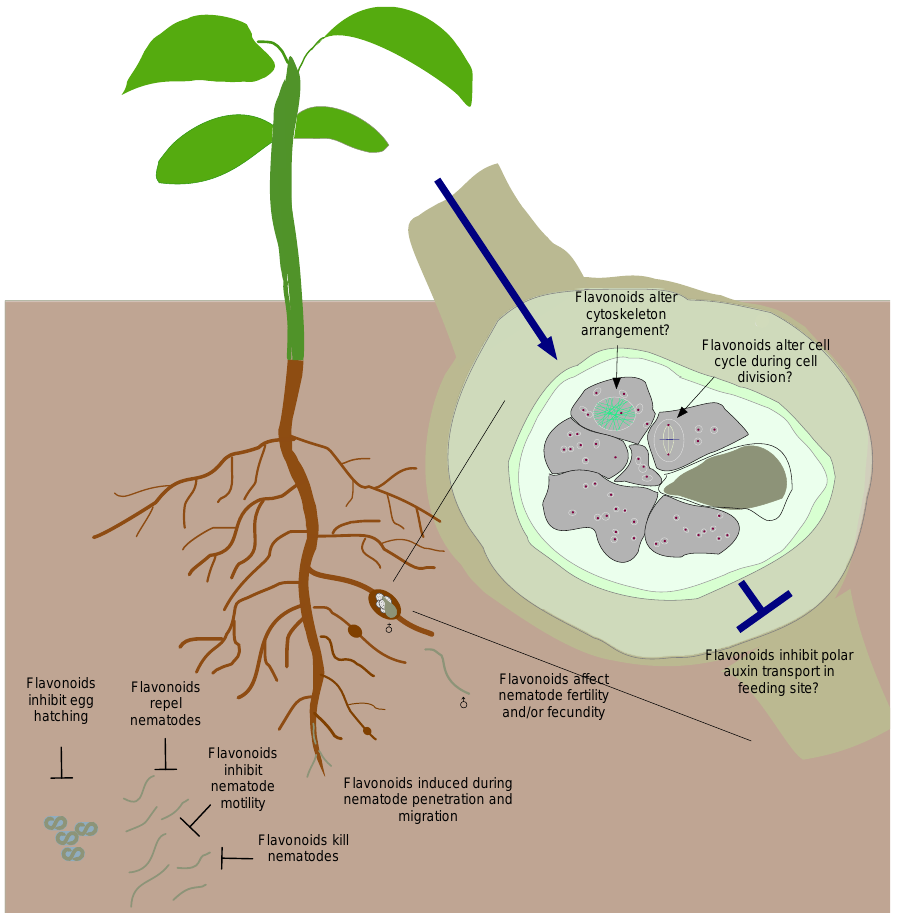
Figure 2. Flavonoids play multiple roles during plant–nematode interactions. The example shown here is for root-knot nematodes. Flavonoids in the rhizosphere can have effects on the pre-parasitic stages by inhibiting egg hatching, repelling hatched nematodes, inhibiting their movement and by killing them. Synthesis of flavonoids is induced when the nematodes penetrate and migrate inside the root; they can act as defense compounds or signals for defense via cross-talk with other defense/stress pathways. Flavonoids can affect adult stages of nematodes by altering their fertility and/or fecundity. The role(s) of flavonoids in feeding site development is less understood. They are postulated to be involved in the inhibition of auxin transport, cell cycle regulation, and cell cytoskeleton rearrangement.